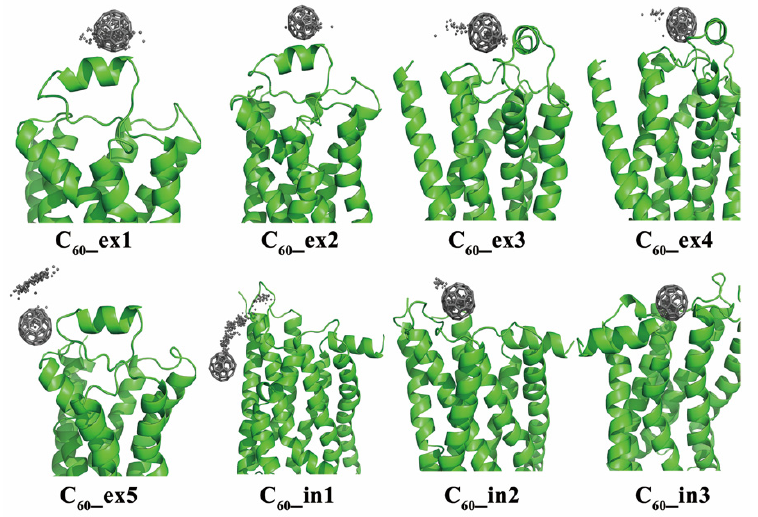
Figure 3. The initial binding sites of monomeric fullerenes in different systems of protein complexes. The black dots represent the center of mass of C 60 along the MD trajectory sampled every 1 ns and the stick is the ending position of C 60 .